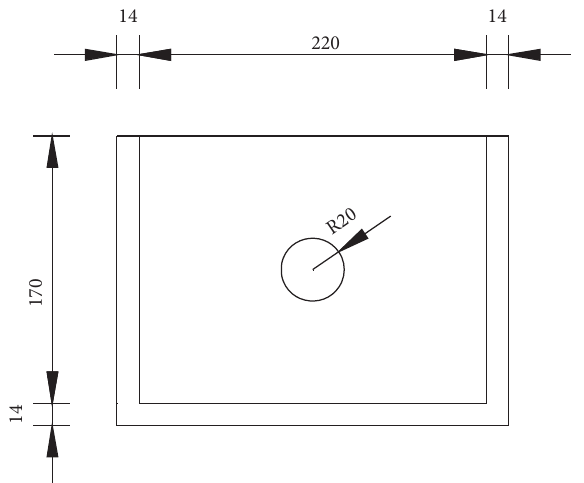
Figure 2: Sectional elevation of the laboratory model test